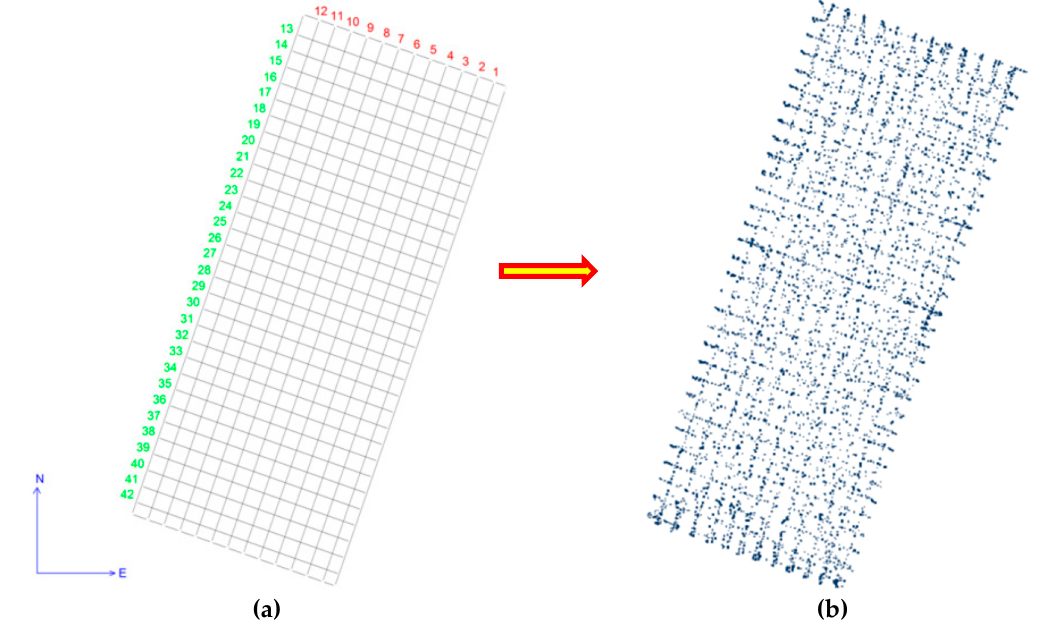
Figure 5. ( a ) The diagram of numbering longitudinal and transverse ground-penetrating radar (GPR) profiles; ( b ) presentation of all 13,763 points determined by the GPR-TPS (terrestrial positioning system) model using a 400 MHz antenna.